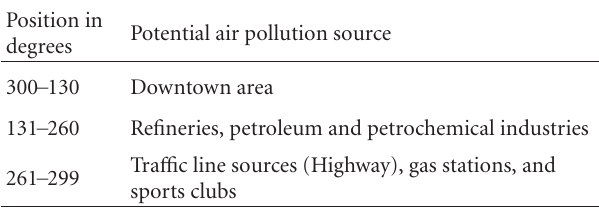
Table 6: Position distribution around outdoor data collection point in Fahaheel urban